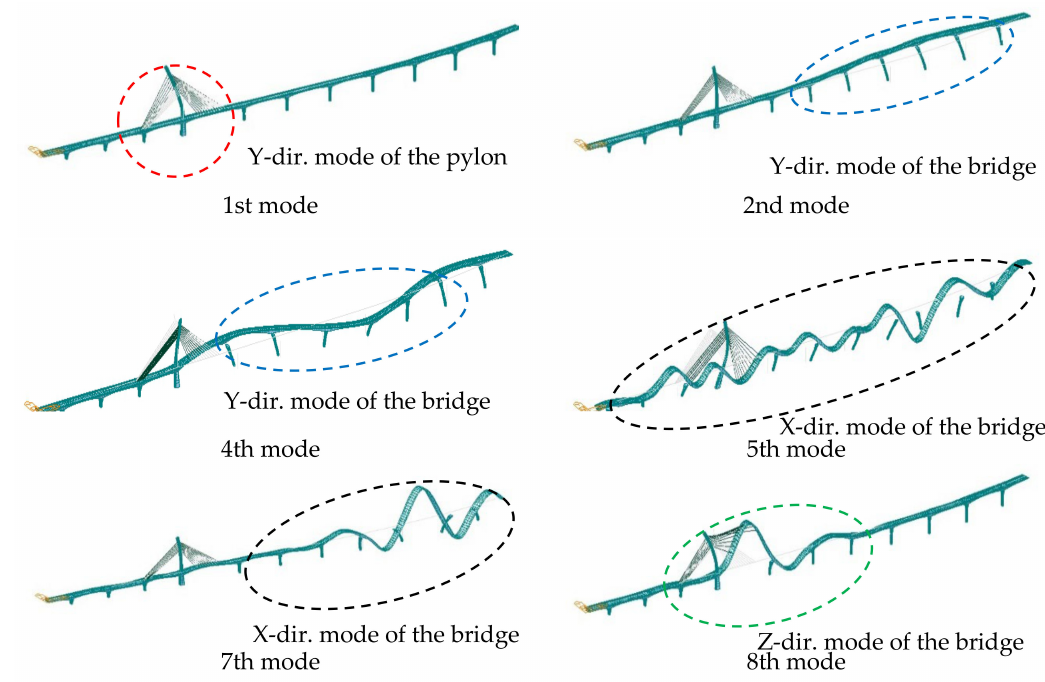
Figure 9. Mode shape configurations using primary sti ff ness (K u